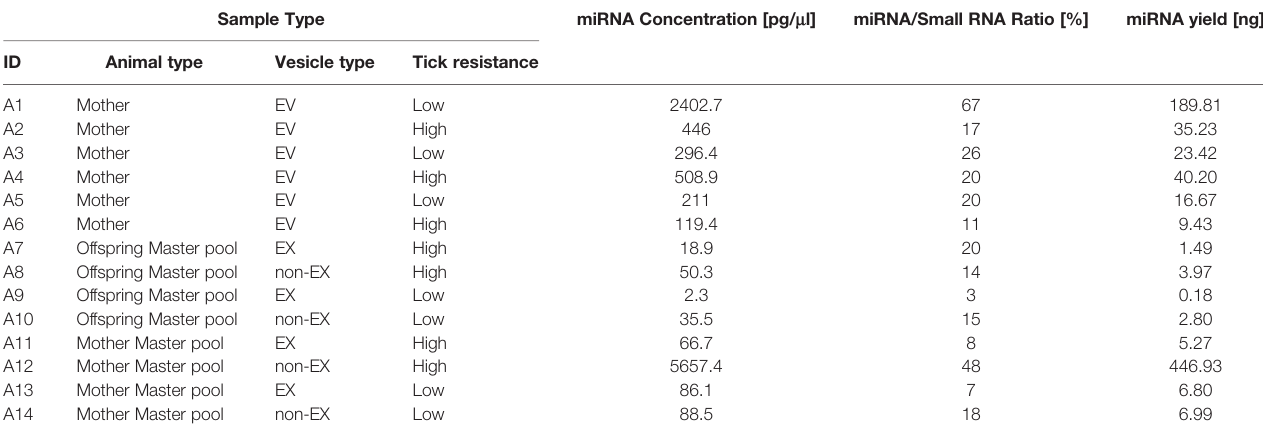
TABLE 2 | Bioanalyzer quality control (QC) results for miRNA